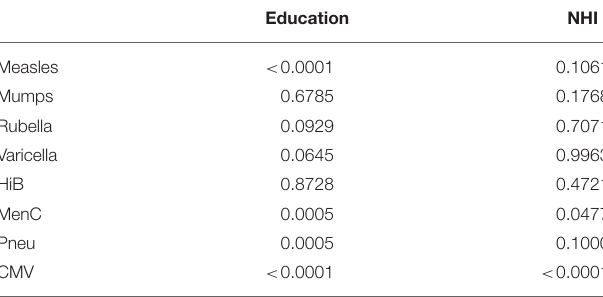
TABLE 2 | P -values for trend across the socioeconomic status categories, education and net household income are analyzed